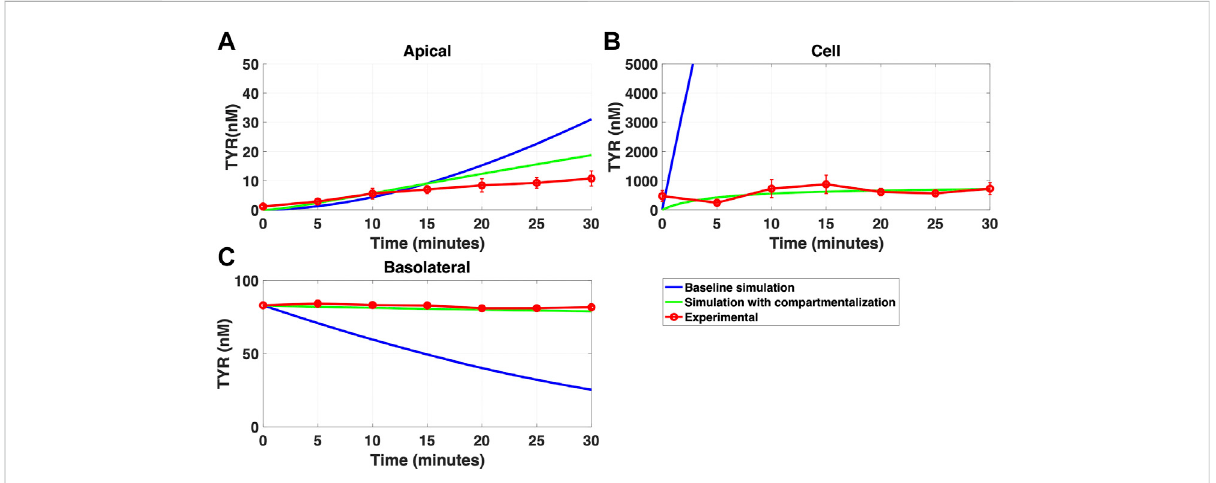
FIGURE 10 Compartmentalization is needed with introduction of symmetry in the facilitated diffusion transporters with basolateral TYR loading. The transport of 82.9 nM TYR across Caco-2 cells was modeled following basolateral loading by solving Eqs 12 – 14, using the values mentioned in Supplementary Table S2, using MATLAB vR 2021a. Comparisons were made between the models (baseline = blue curve; modi fi ed = green curves) and experimental observations;redcurve(Sarkar andBerry,2020)for theapical Panel 10 (A) , cellularPanel 10 (B) and basolateralcompartments Panel 10 (C) . When symmetry is introduced in the facilitated diffusion transporters, compartmentalization is needed. Kinetic parameters used for this modelling were: V max_OCT2 = 2.3 nM/s, K t _OCT2_apicaltocell = 110.4 nM, K t _OCT2_celltoapical = 110.4 nM, V max_baso_active = 3.3 nM/s, K t_baso_active